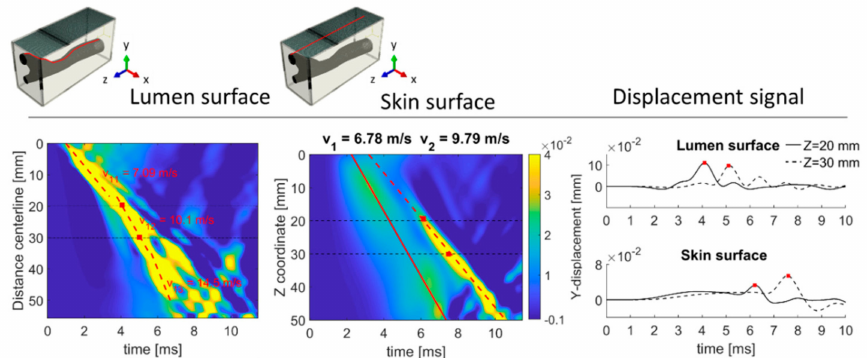
Figure 9. TOF plots at the lumen and skin surface for the CA model under traveling impulse condition (V z of 7 m / s). Note that the TOF plot of the lumen is plotted along the centerline distance instead of the Z coordinate. The temporal profile of the y-displacement is shown for locations at z = 20 and 30 mm.